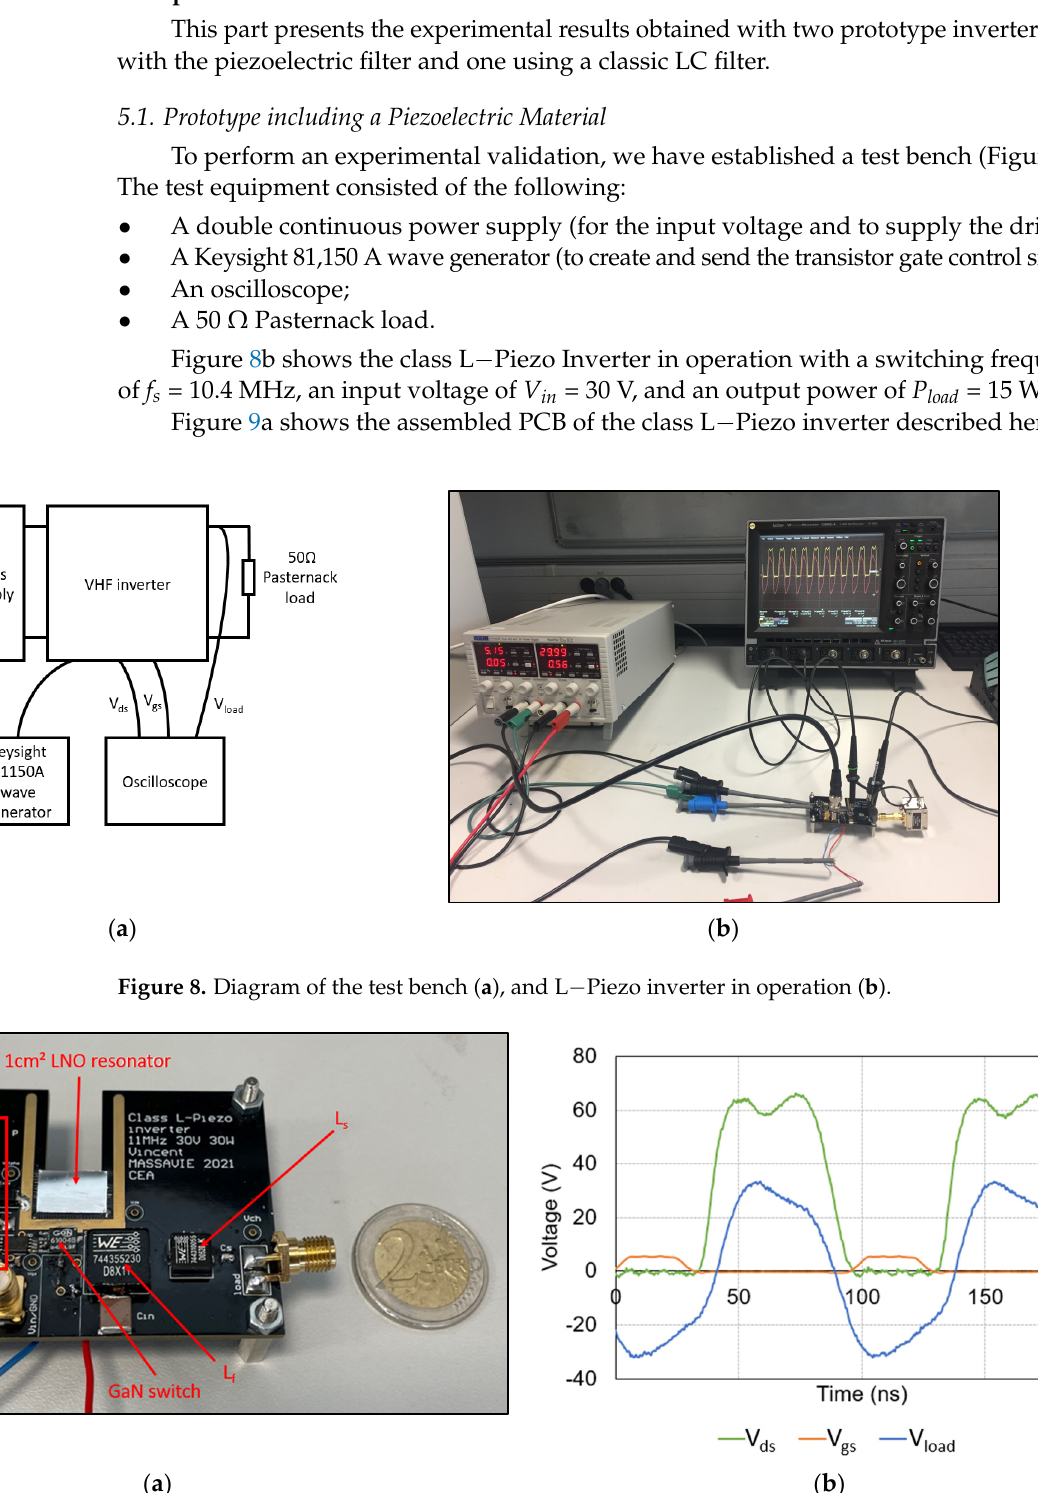
Figure 9. Prototype with piezoelectric filter ( a ), and characteristic voltages of the L − Piezo inverter